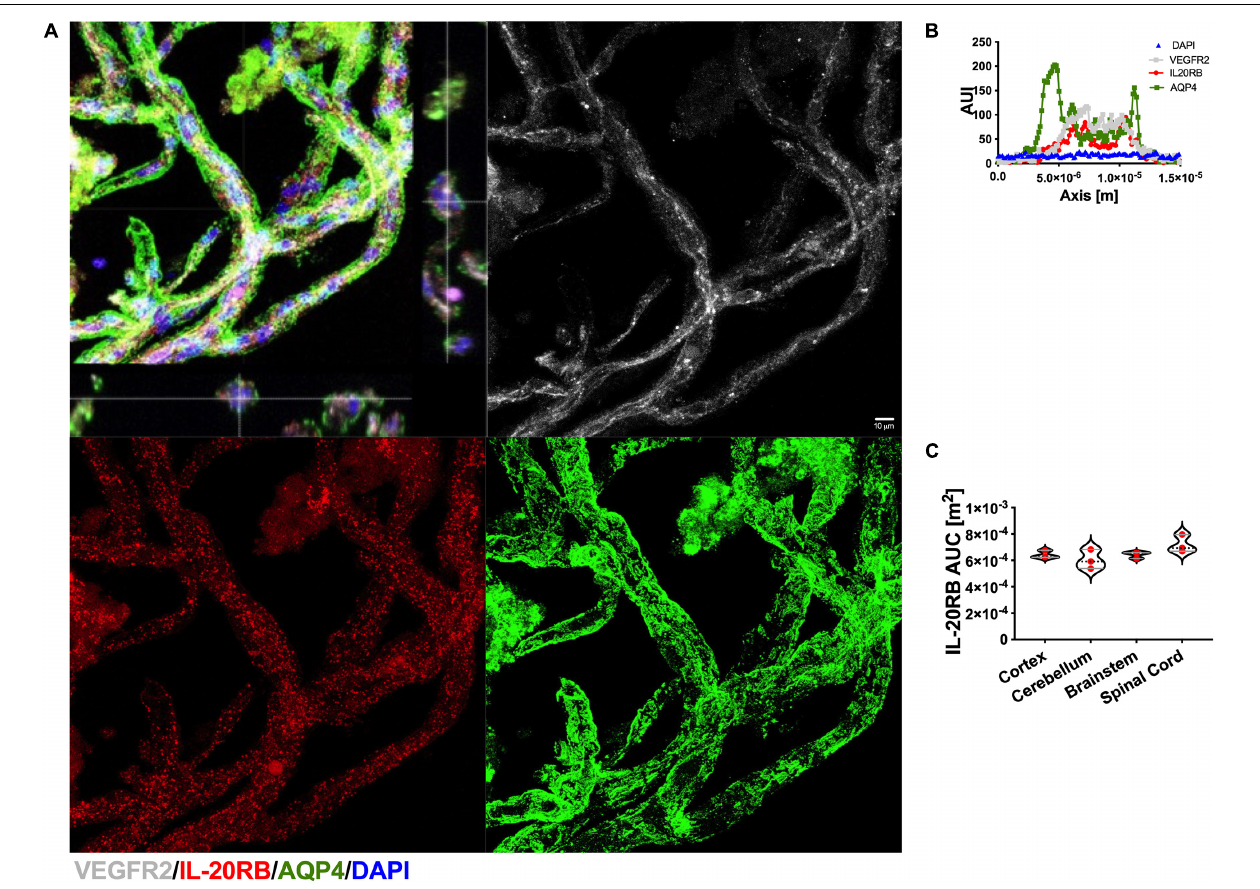
FIGURE 5 | IL-20 receptor subunit β expression on rhesus macaque CNS microvessels. CNS region-specific microvessels were isolated from macaque tissue, n = 3, to elucidate IL-20RB protein expression by immunolabeling for VEGFR-2 (white, endothelial marker), IL-20RB (red), AQP4 (green, astrocytic end-feet marker), and DAPI (blue), scale bar = 10 µ m (A) . VEGFR-2 colocalized with IL-20RB confirming endothelial cells expression of IL-20RB whereas AQP4 appears to envelop both. Histogram analysis was performed to 50 microvessels per specimen and CNS region to determine microvessels diameter and AUI for IL-20RB expression (representative AUI vs. axis plot, B ). One-way ANOVA analysis followed by Sidak’s post hoc test showed no statistical significance between AUC means for the different CNS regions (mean ± SD cortex: 6.4 × 10 − 4 ± 2.9 × 10 − 5 , cerebellum: 6.0 × 10 − 4 ± 7.3 × 10 − 5 , brainstem: 6.4 × 10 − 4 ± 2.5 × 10 − 5 and spinal cord: 7.1 × 10 − 4 ± 6.7 × 10 − 5 , C ). Results are shown as mean ±